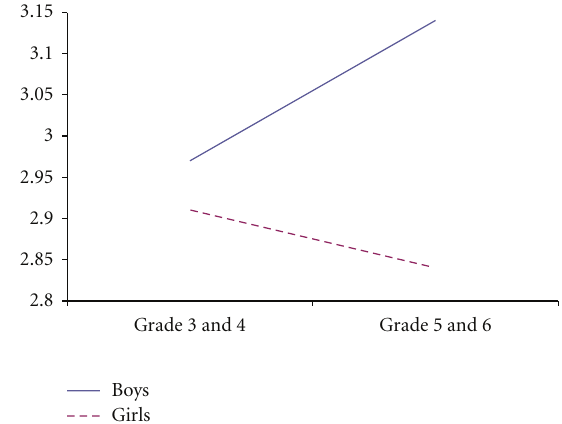
Figure 2: Sex by grade interaction for academic self-concept.